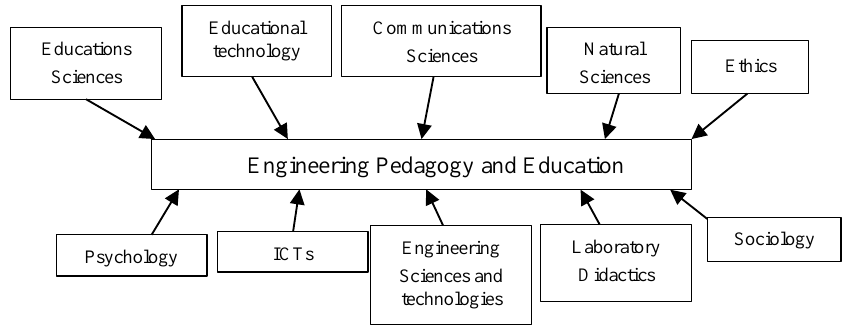
Fig. 1. Fields which influence engineering pedagogy and